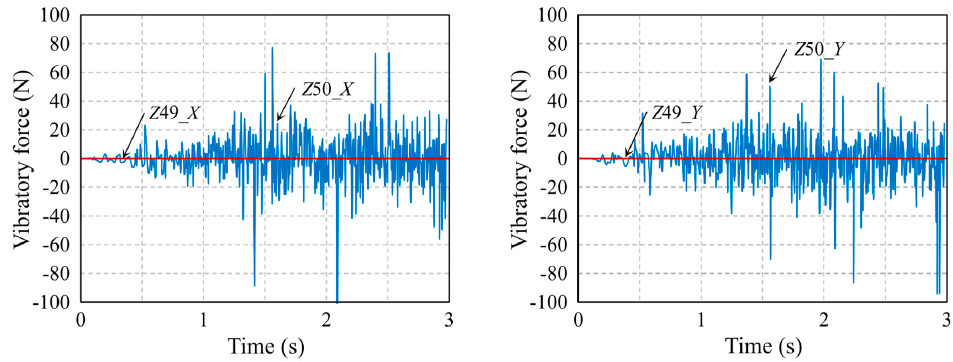
Figure 7. Vibratory forces at the center of the reducer at a maximum speed (_ X : x-axis direction, _ Y : y-axis direction).